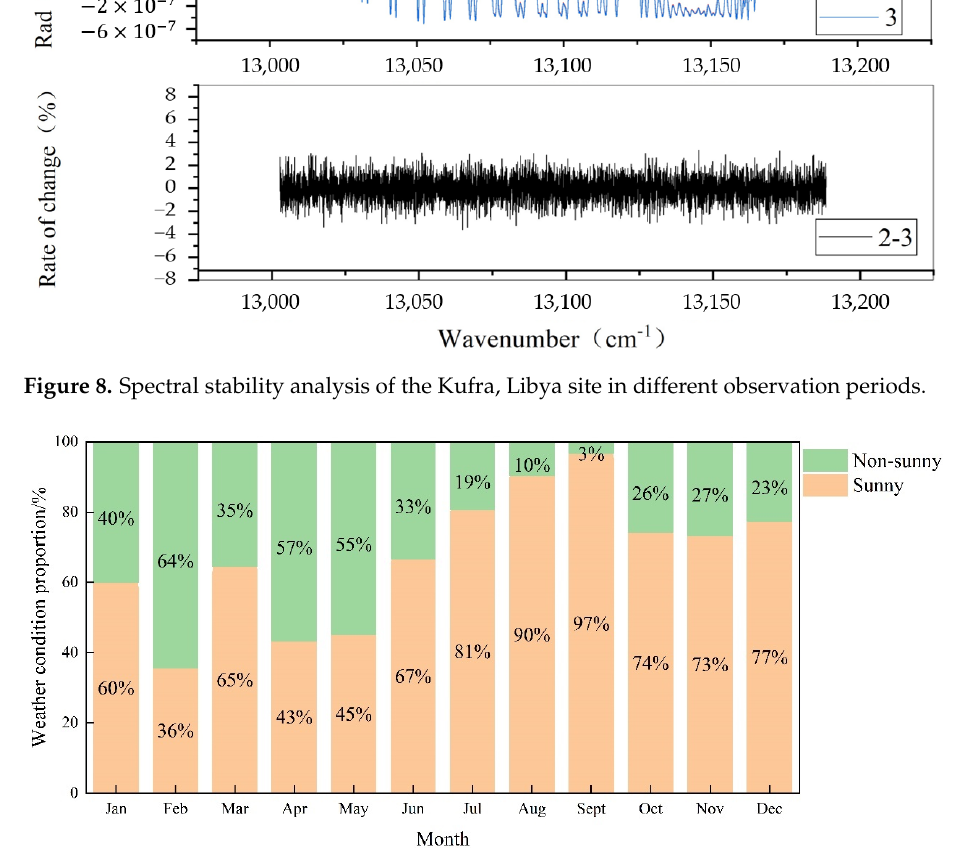
Figure 9. Statistical chart of weather conditions at the Kufra, Libya site in 2018.